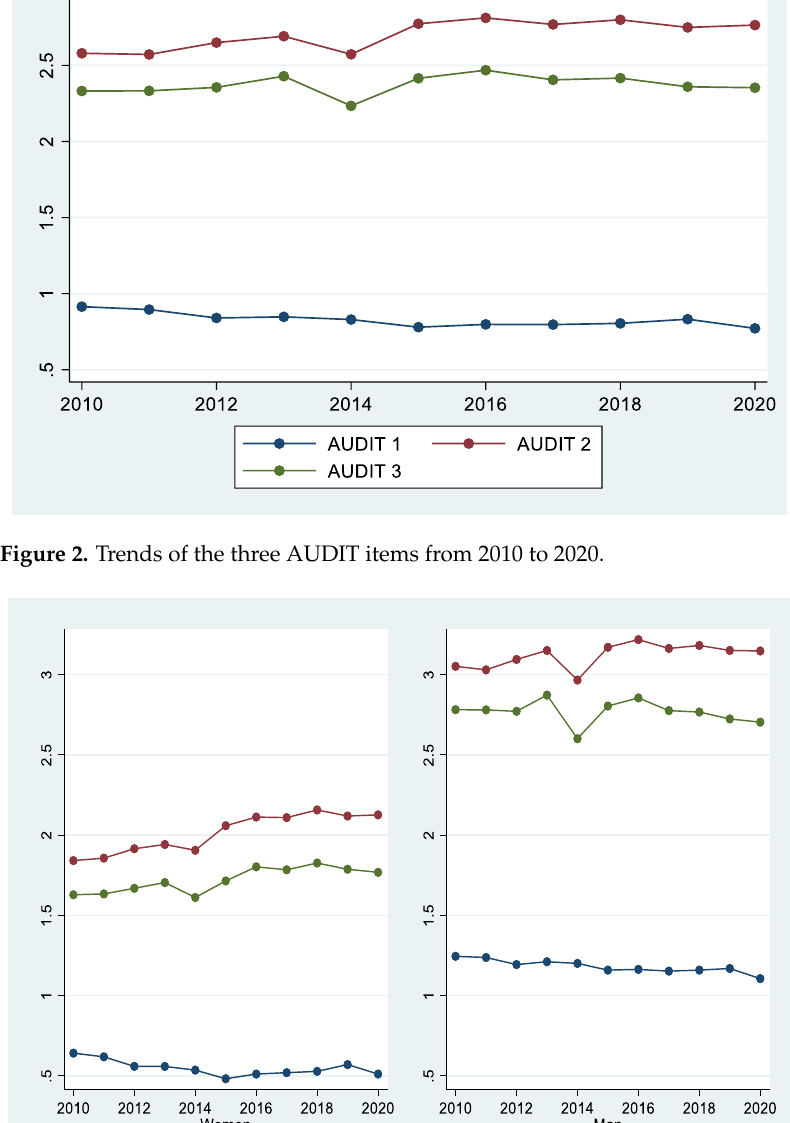
Figure 2. Trends of the three AUDIT items from 2010 to 2020.